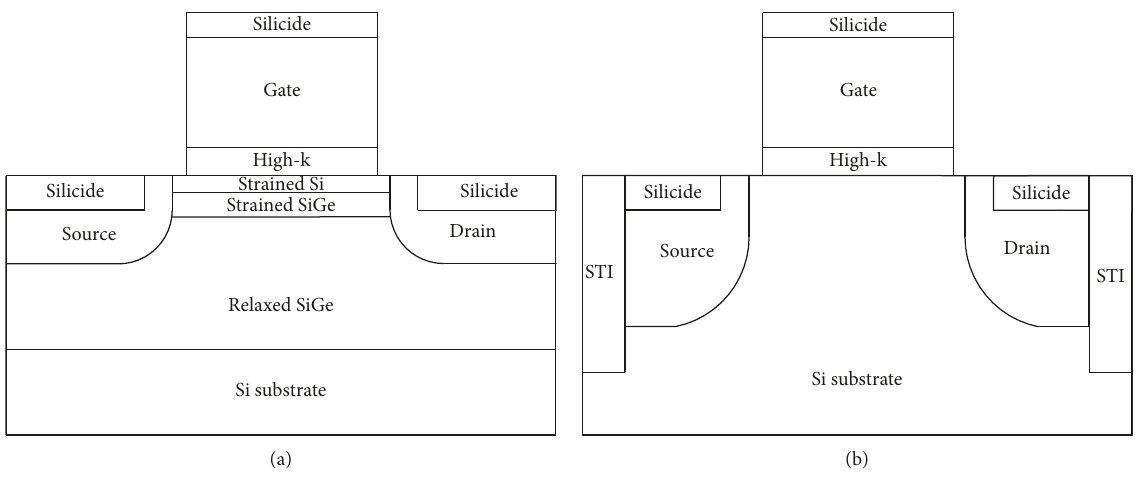
Figure 3: MOS transistor (a) with a strained Si-channel and (b) without a strained